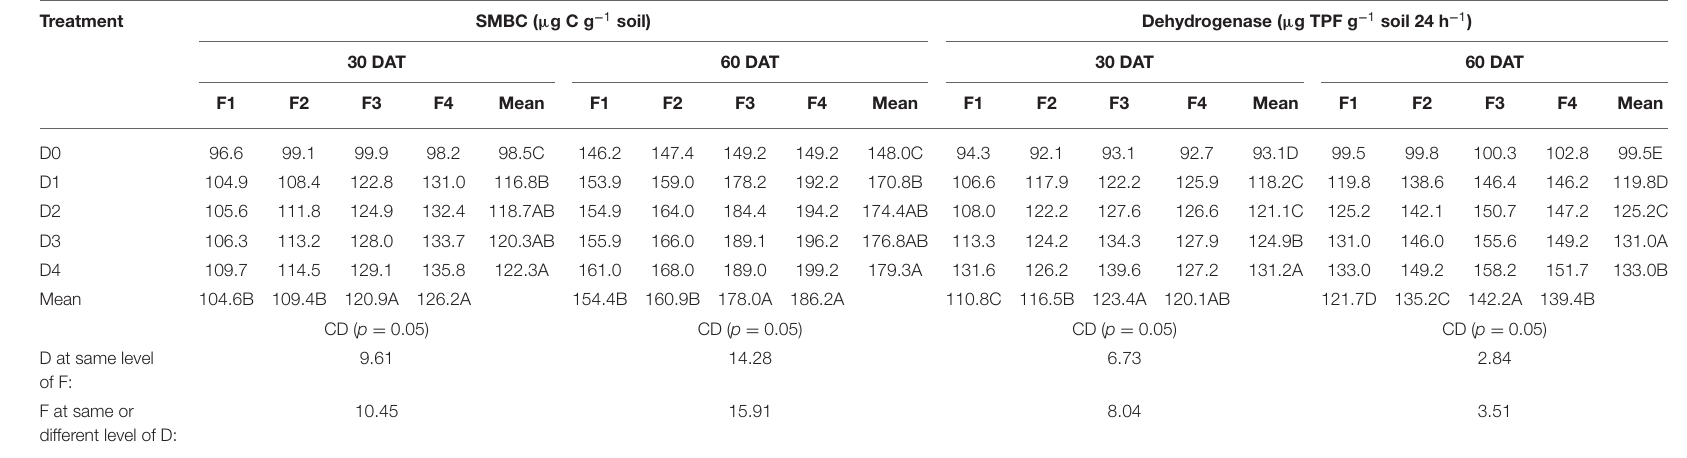
TABLE 8 | Interaction effect of RDF and panchagavya on soil SMBC and Dehydrogenase at 30 and 60 DAT.